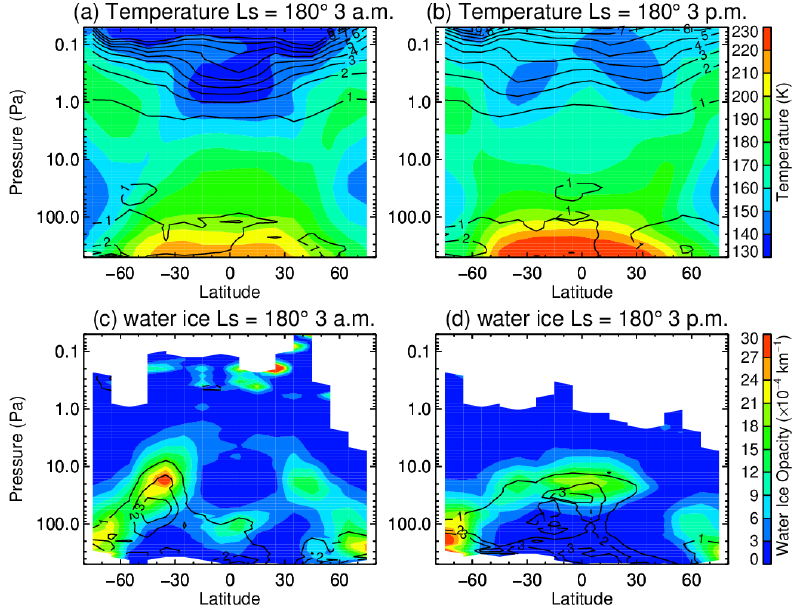
Figure 2. The zonal mean nighttime ( a , c ) and daytime ( b , d ) MCS temperature ( a , b ) and water ice ( c , d ) retrievals at the northern fall equinox ( Ls = 180° and 5° averaged). The black contours in each ◦ and 5 ◦ averaged). The black contours in each panel indicate the data uncertainty. ( c , d ) retrievals at the northern fall equinox ( Ls = 180 panel indicate the data